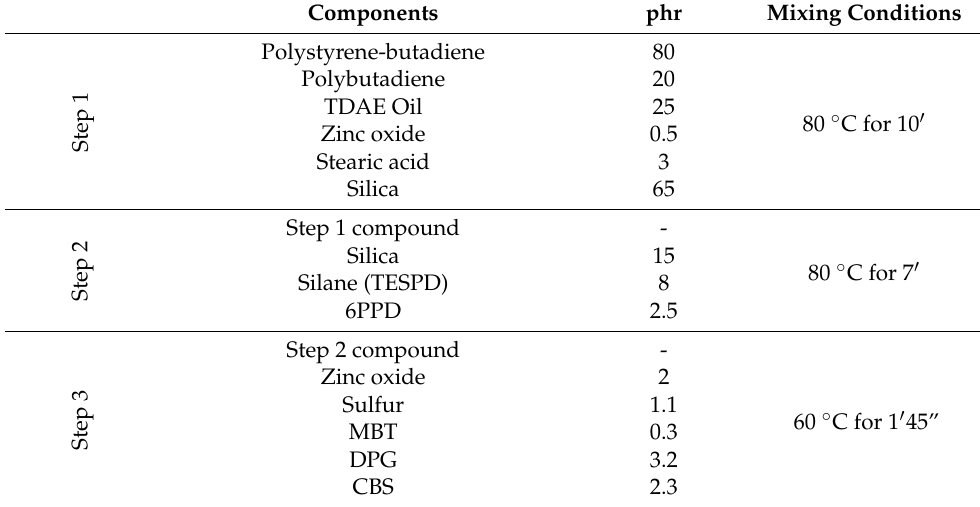
Table 1. Composition and mixing steps for silica-rubber composite fabrication. Components